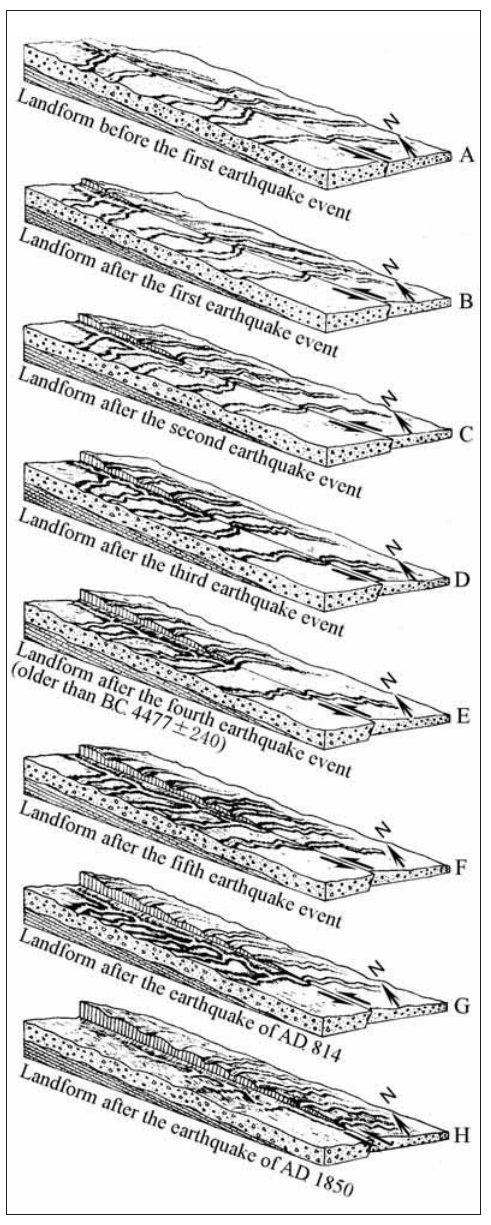
Fig. 6. Sketch showing the evolutionary scenario of ravines on the top of the Daqingliangzi uplift formed in association with large magnitude earthquakes on the Zemuhe